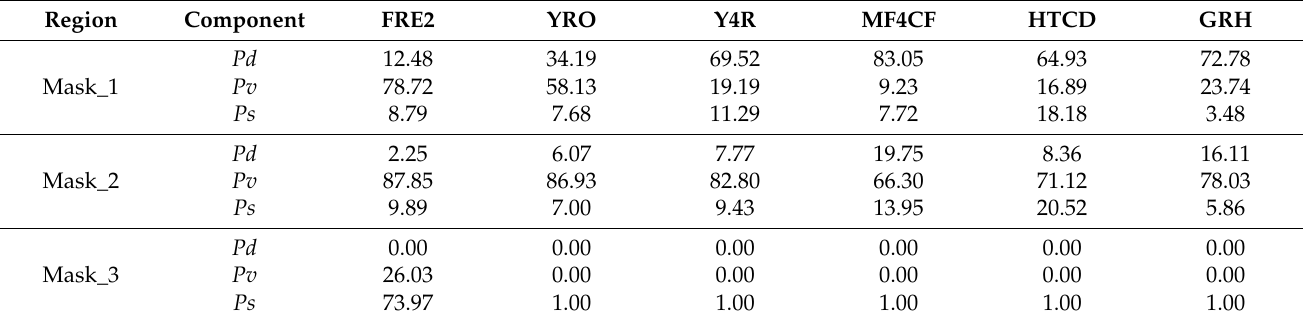
Table 3. The percentage of each polarization component of all methods in the three masks (%).